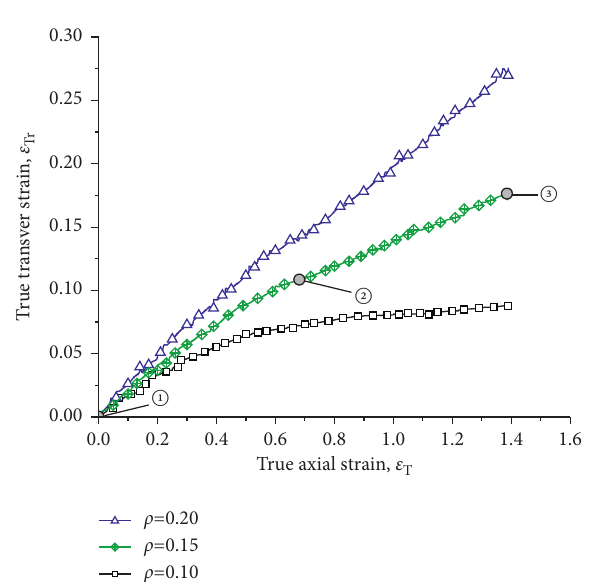
Figure 7: Relationship between the transverse and axial true strain.